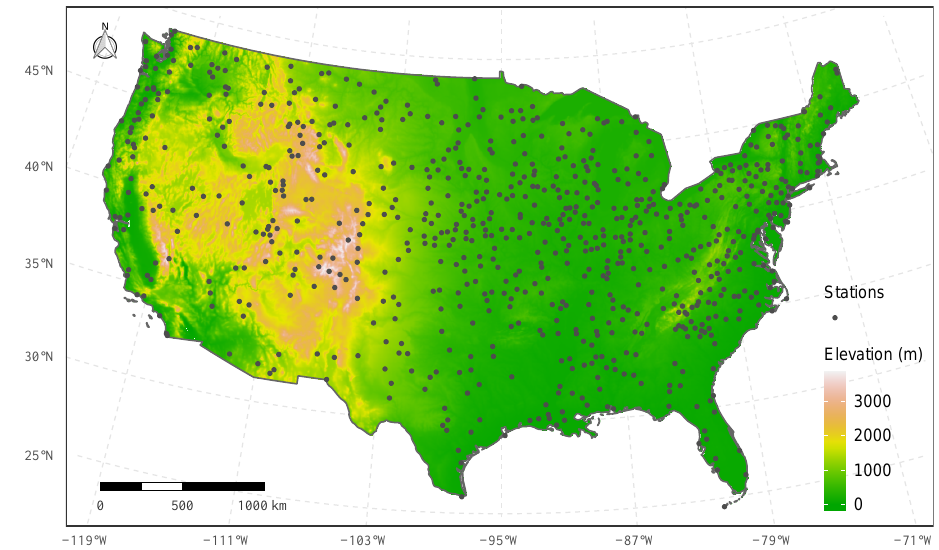
Figure 1. The study area and the spatial distribution of ground stations, accessed from NOAA NCDC.